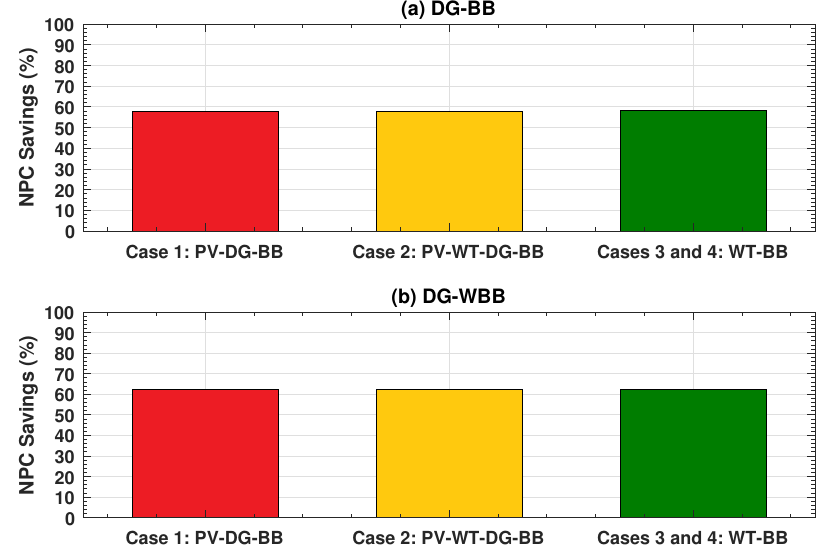
Figure 9. NPC savings of Jal-Alayah cell-site with respect to the: ( a ) DG-BB and ( b ) DG-WBB config-